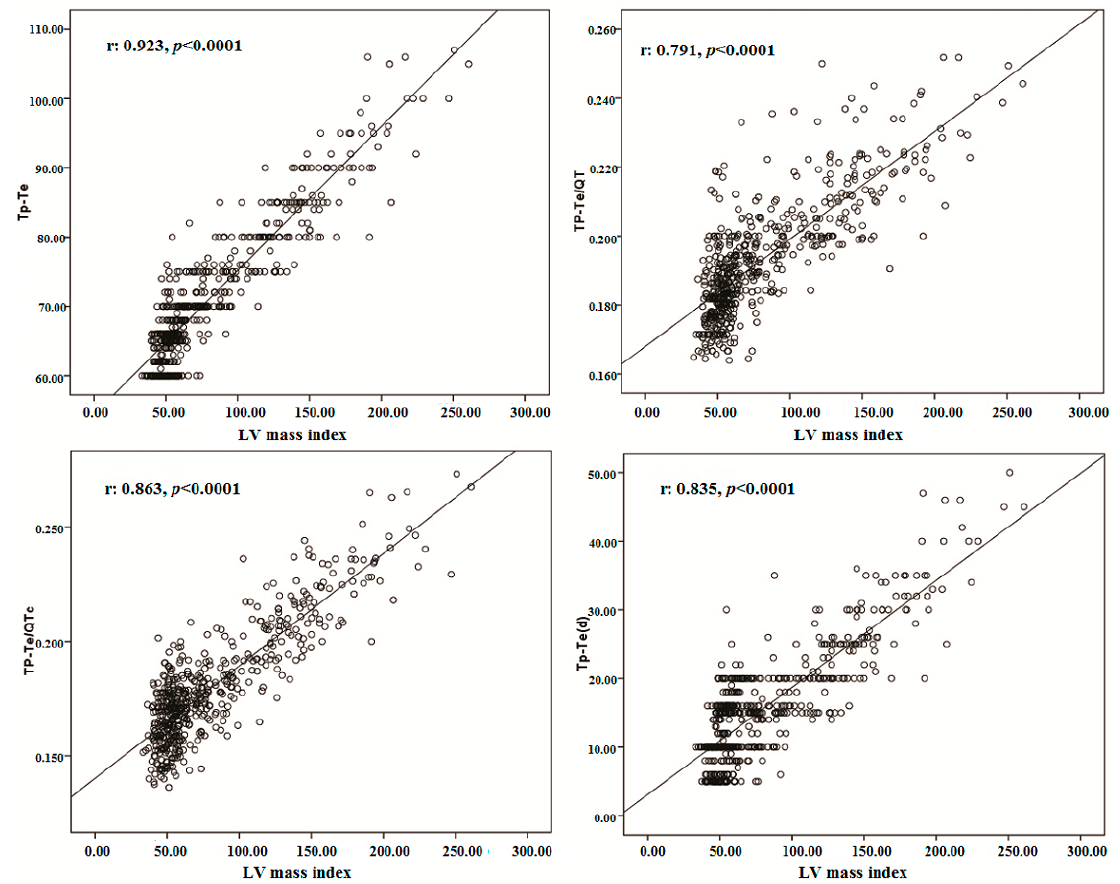
Figure 3. The correlations between Tp-Te, Tp-Te/QT, Tp-Te/QTc, Tp-Te (d) and LV mass index.